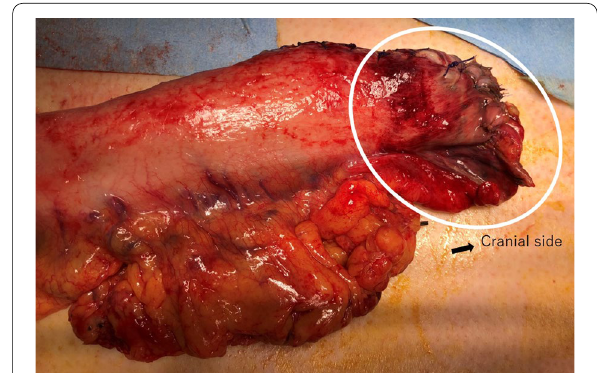
Fig. 1 Intraoperative findings in case 1 at the time of reoperation. The tip of the gastric conduit above the manubrium was necrotic from strangulation as a result of compression by the sternoclavicular joint (white circle)